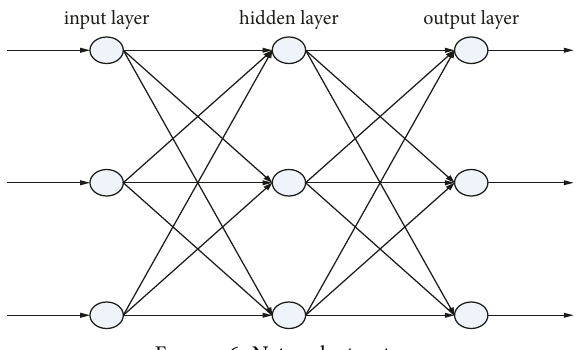
Figure 6: Network